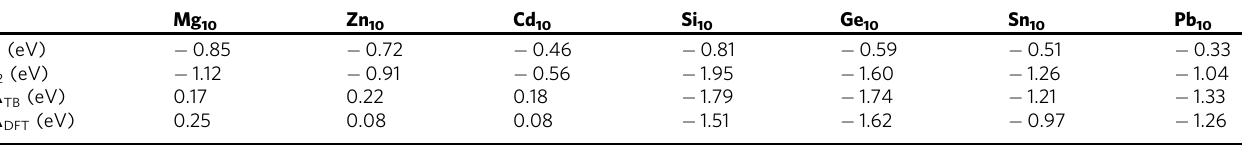
Table 1 The evaluated parameters by DFT calculations